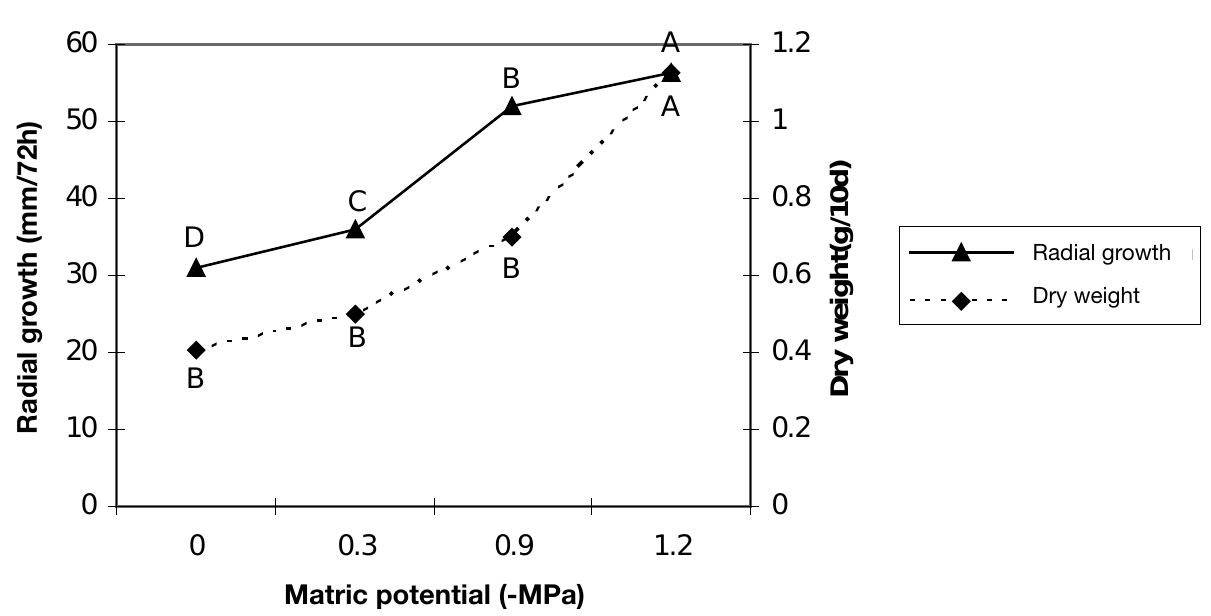
Fig. 3. Effect of matric potential on the radial growth and dry weight of Macrophomina phaseolina mycelia. Signi fi cant differences between treatments are indicated by different capital letters (Duncan, P ≤